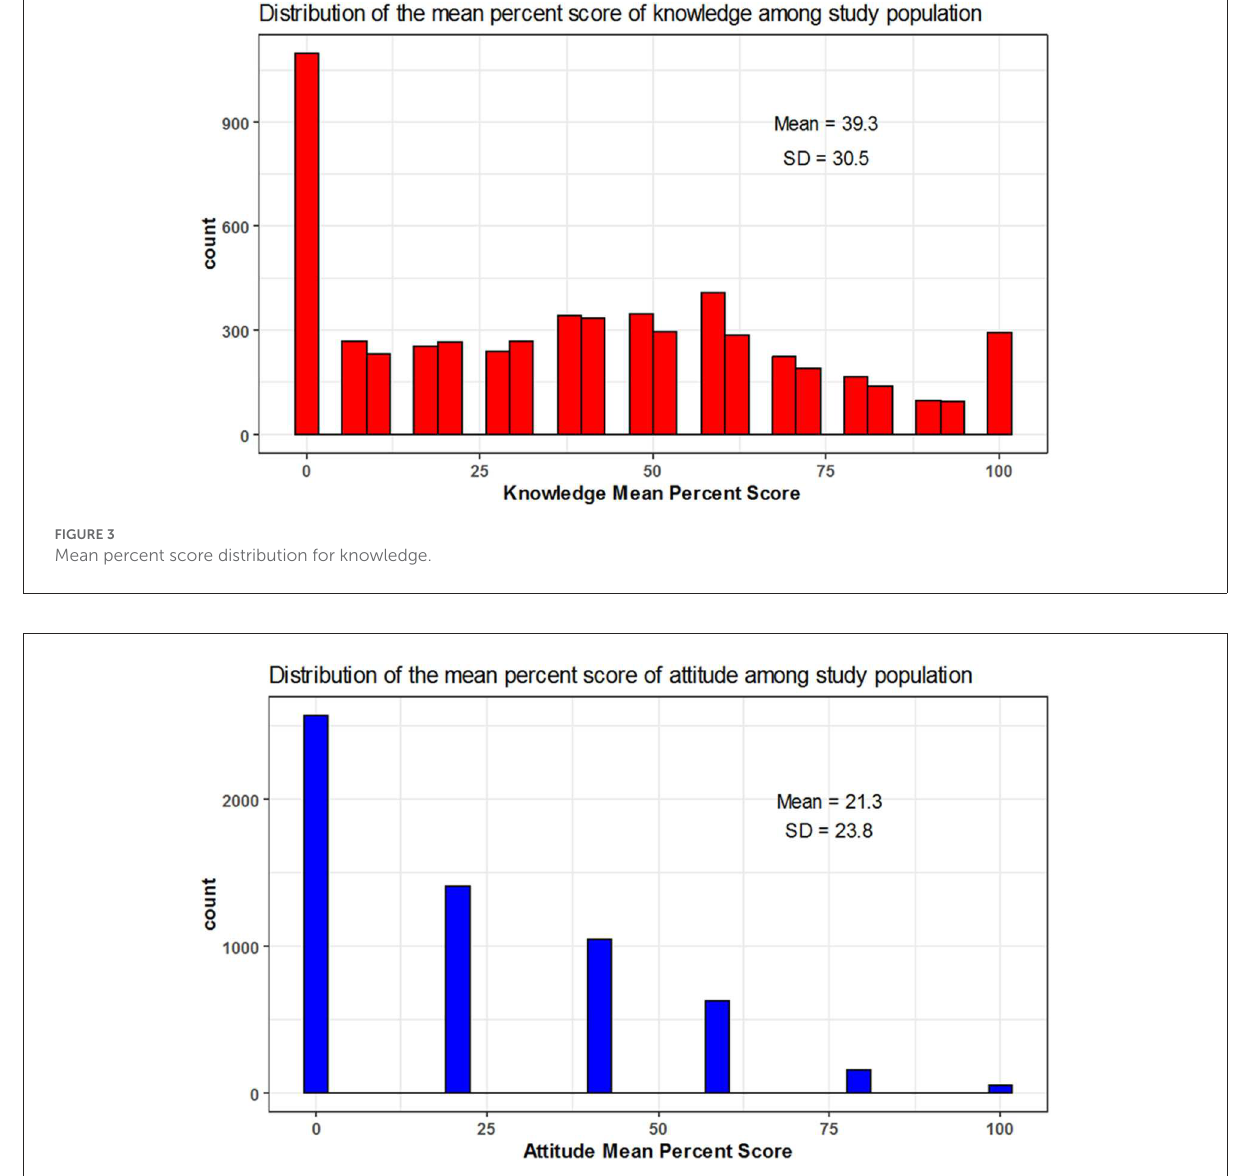
about 53% when compared to Algerian participants (OR = 0.47, 95% CI: 0.23–0.90, p =